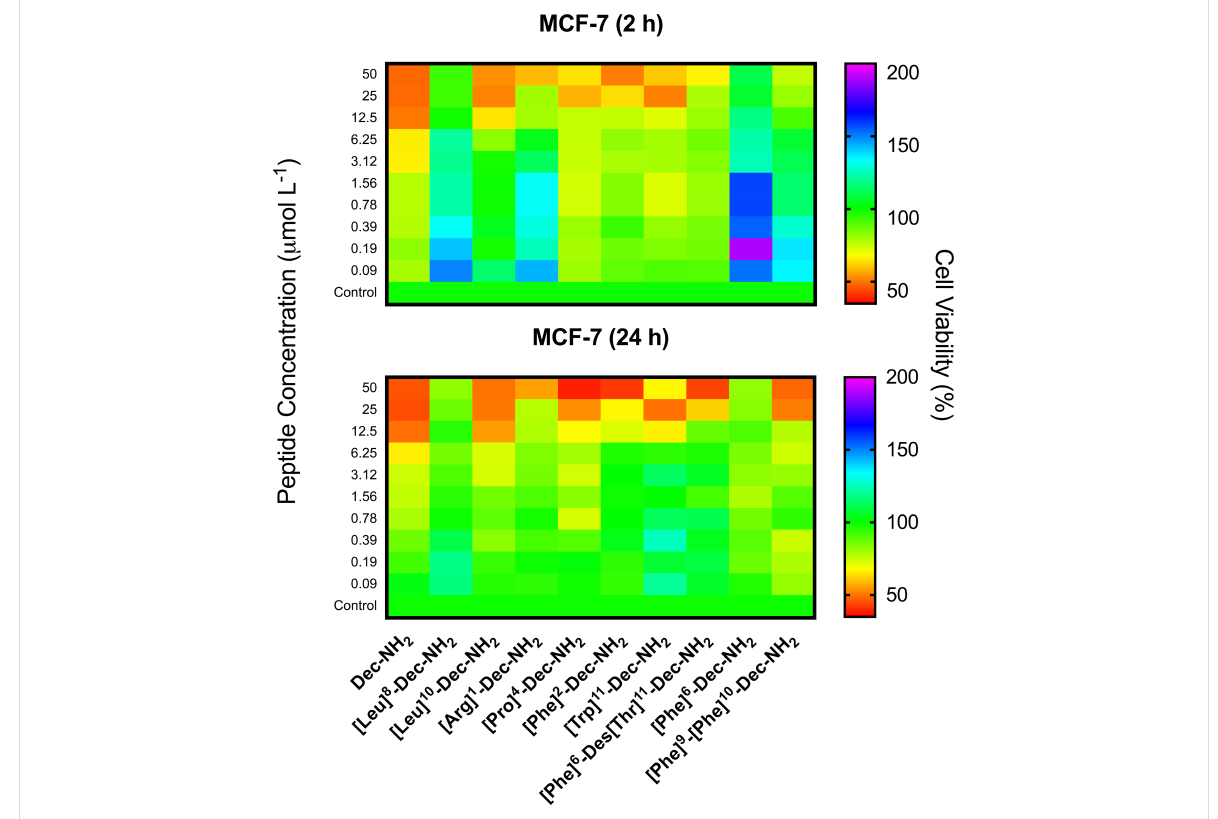
Figure 2: MTT assays using Dec-NH 2 and its synthetic analogs after 2 and 24 h of exposure to MCF-7 cancer cells. Experiments were done in tripli- cate.